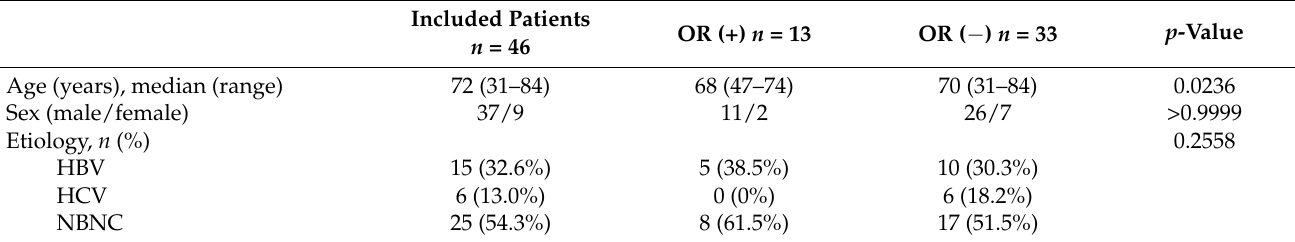
Table 2. Baseline characteristics of patients with or without an